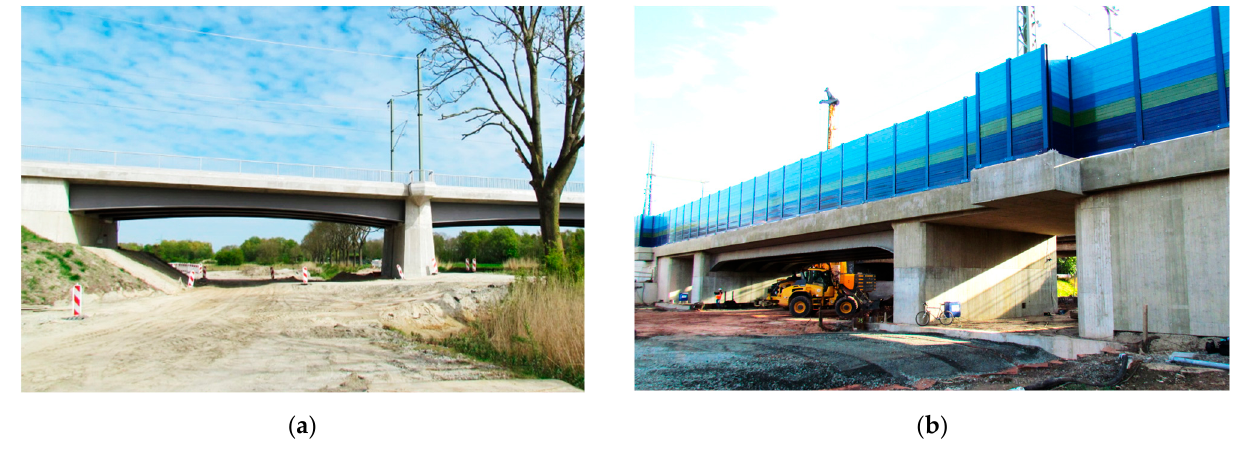
Figure 29. Two German bridges equipped with flexible monolithic DFOS sensors: ( a ) near the city of Sande; ( b ) near the Frankfurt am Main.